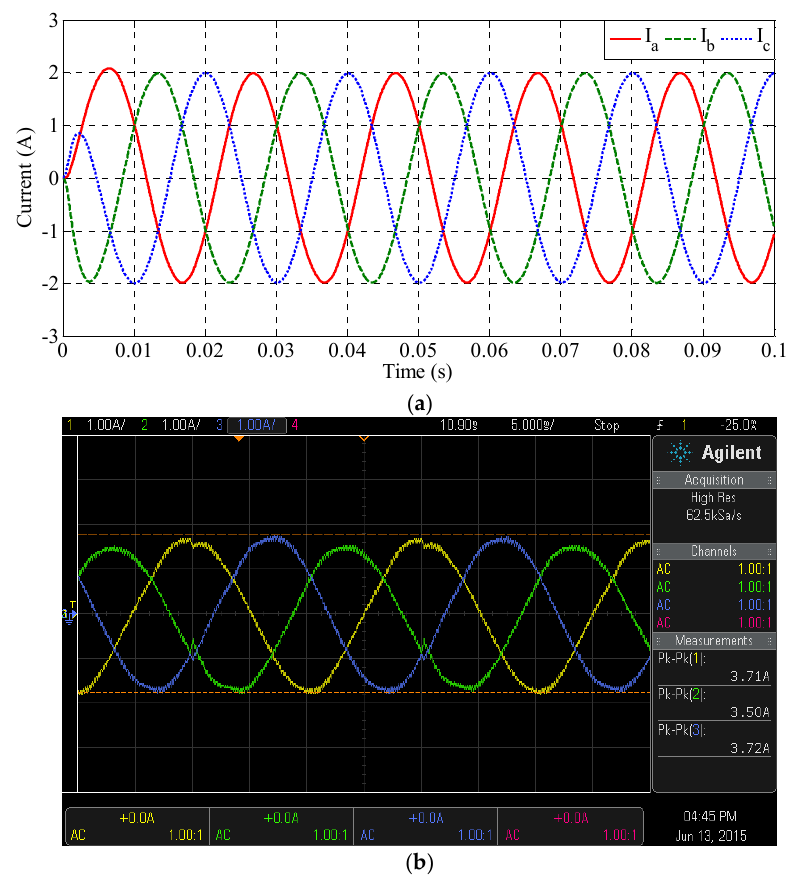
Figure 23. Output current waveforms ( i.e. , I a , I b , and I c ) of the three-phase inverter with RL load for ( a ) simulation and ( b ) experimental.